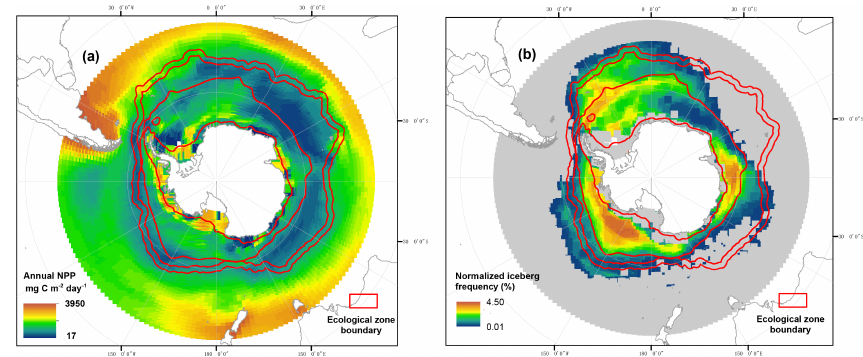
Figure 2. Spatial distribution of annual mean NPP (a) and normalized iceberg frequency (b) in relation to ecological zones. Table 1. Mean annual primary production of ecological zones of the SO 2002–2014. Zones Total area Area of productive Total annual NPP over productive NPP over all waters (millionkm 2 ) grids production waters